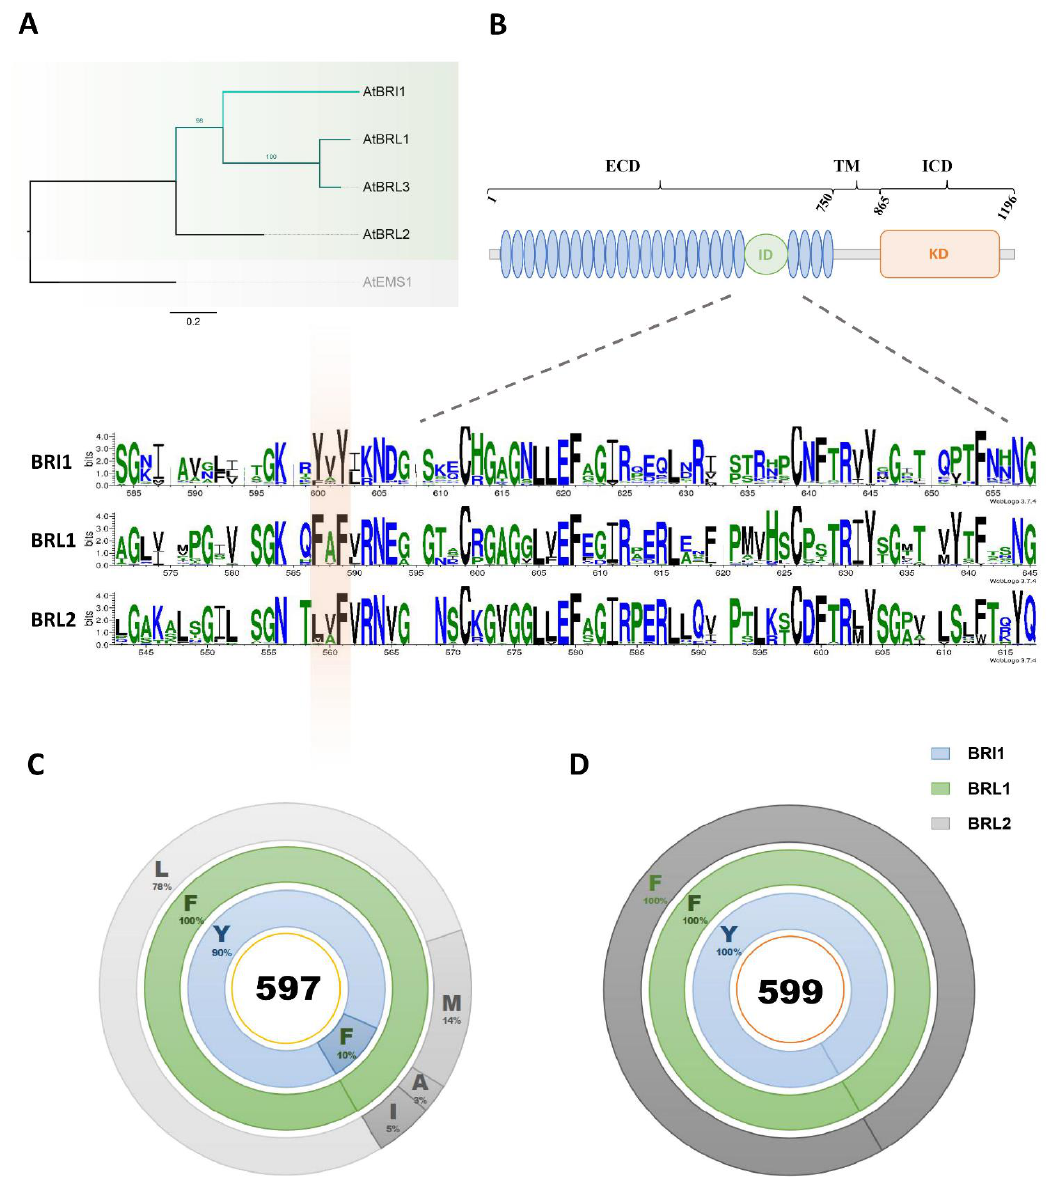
Figure 1. Two residues are fixed in the ID of BR receptors for BR perception. ( A ) Phylogenetic rela- tionship of BR receptors — BRI1 and BRL1/3, and non-BR receptor BRL2. The phylogeny was gener- ated by the IQ-TREE web server, and the confident values were estimated using the SH-aLRT branch test with 1000 replicates. EMS1 served as an outgroup. Gray branches indicate non-BR re- ceptors, while green and blue branches highlight the BR receptors. ( B ) Schematic representation of a typical BR receptor with an extracellular domain (ECD), a transmembrane domain (TM), and an intracellular domain (ICD), and the Sequence logos ’ analysis presenting the conservations of the ID among BR receptors. Colors of symbols in Sequence logos show different hydrophobicity, while the symbols ’ stack indicates the conservation of a residue in the sequence. Two conserved residues (597 and 599 of AtBRI1) are highlighted in the orange background. ( C ) Donut charts of the amino acid probability of residue 597 in BRI1 (blue donut), BRL1/3 (green donut), and BRL2 (grey donut).